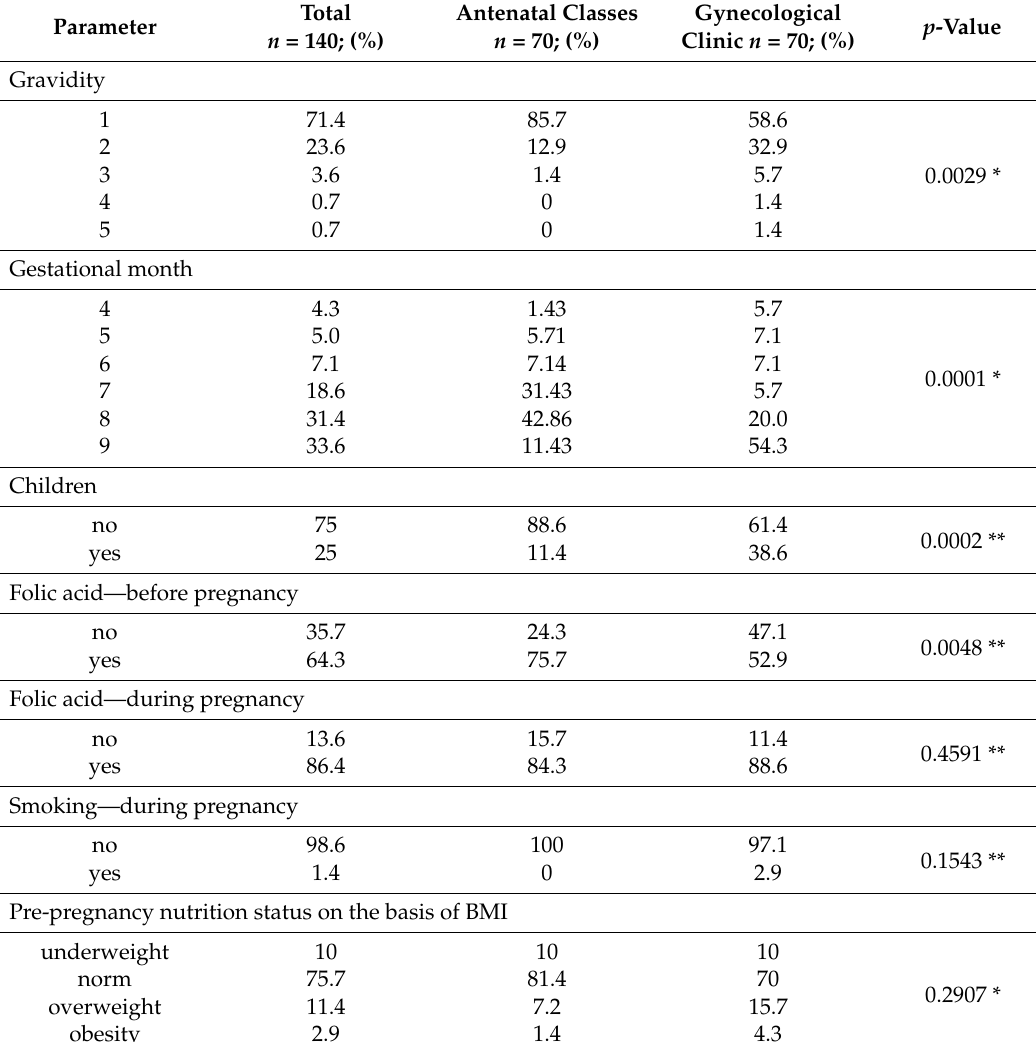
Table 3. Pregnancy and health behaviors of the pregnant women, in total and by